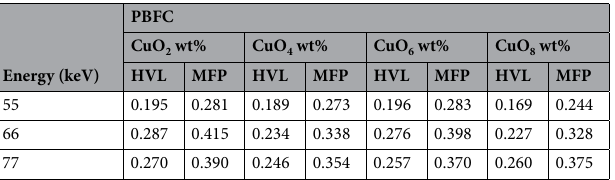
Table 2. Half value layer (HVL) and mean free path (MFP) of PBFC for various amount of CuO in composites.